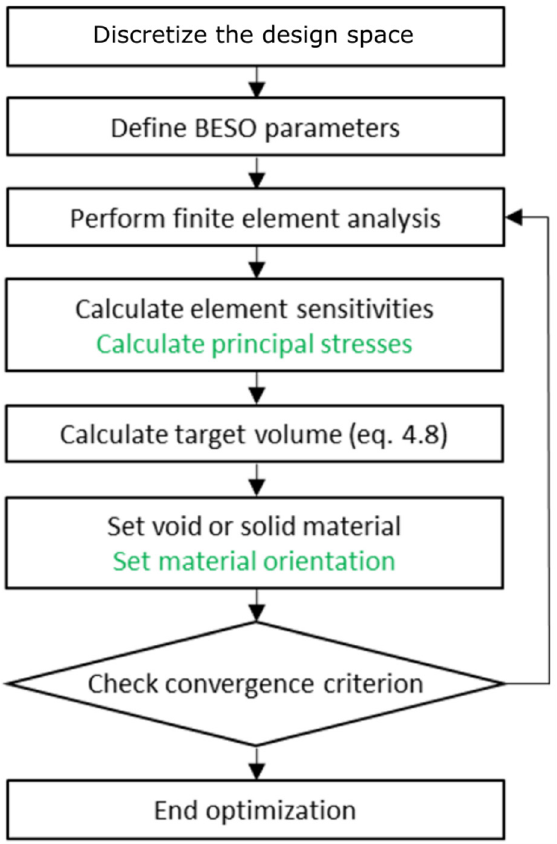
Figure 7. Summary of the BESO method with integrated optimization of fiber-angle. Additionally, to the method described in Figure 4, in dependence of the max. absolute principal vector the local material orientation is assigned.